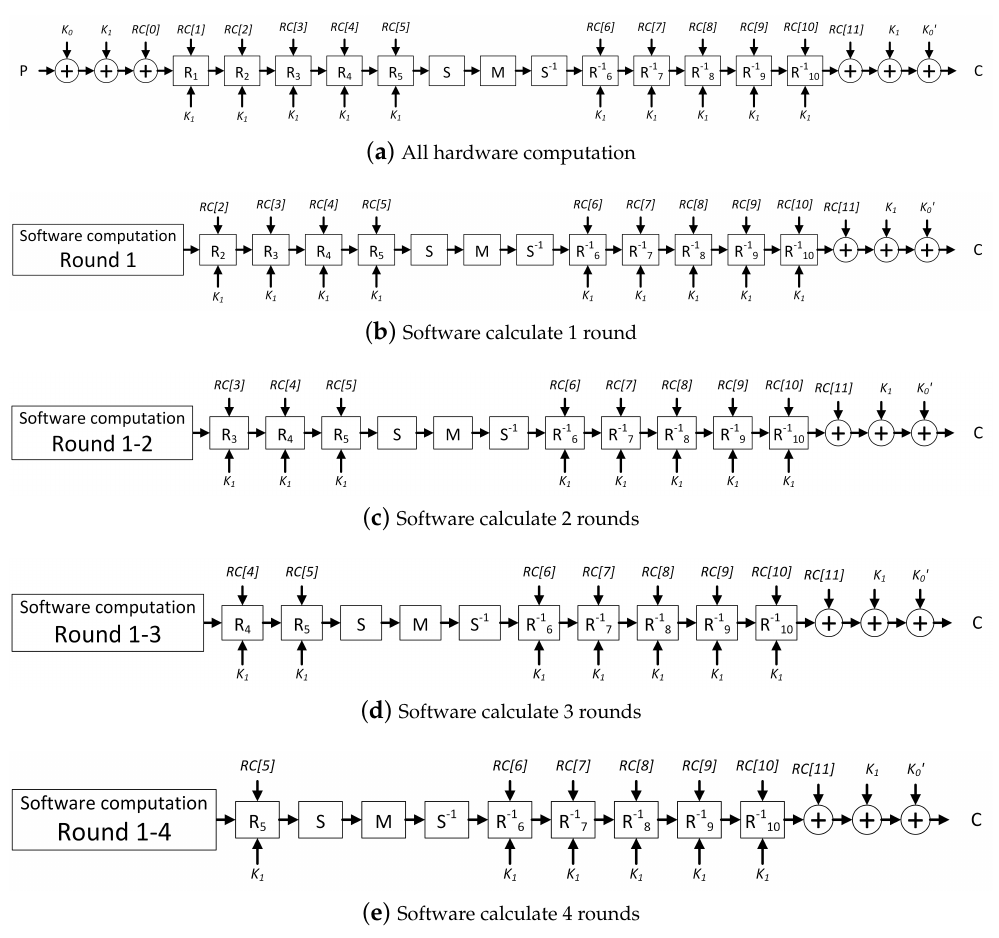
Figure 10. Five implementations of PRINCE in unrolled